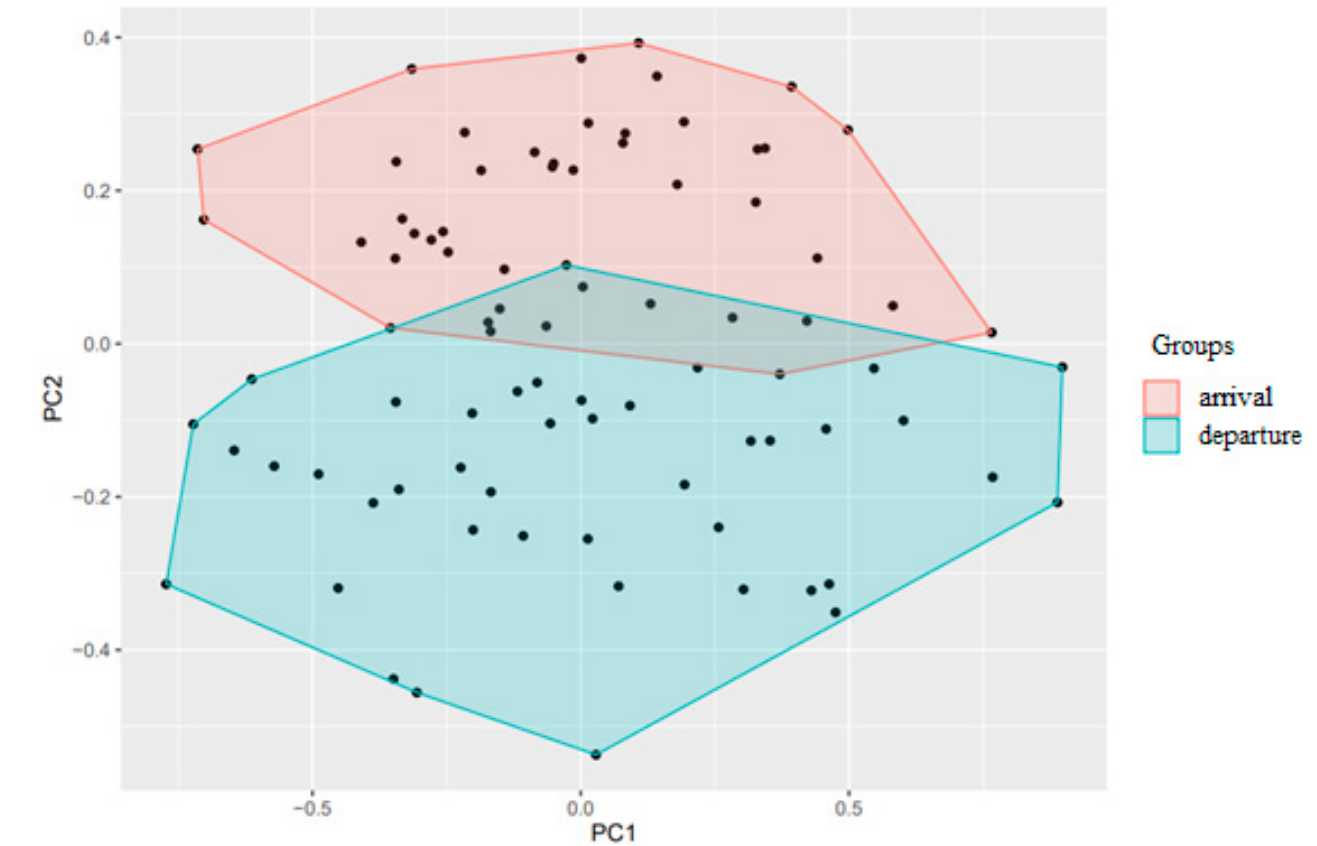
Figure 3. Patient Groups Analyzed by Principal Component Analysis with Local Discriminant Fisher Analysis.